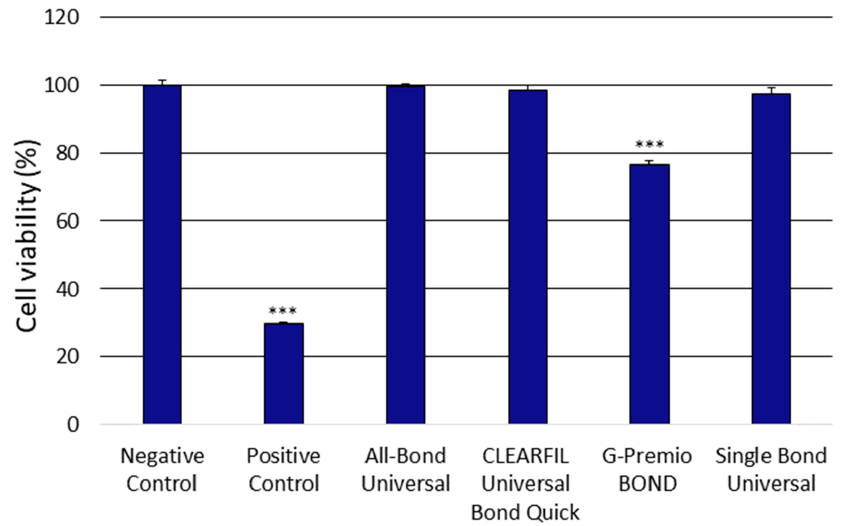
Figure 1. Cytotoxicity of the investigated adhesives. Test performed using the Cell Proliferation Kit II (XTT) assay after 24 h incubation of cells with the tested compounds. The positive control constituted cells were suspended in 96% isopropyl alcohol, while the negative control cells were cultured in a complete medium. The differences were statistically significant on the graphs as follows: *** p < 0.001 versus negative control. 3.2. Analysis of the Genotoxicity of the Universal Dental Adhesives A significant increase in DNA damage was observed after the 24 h incubation in the cells treated with G-PREMIO Bond. The other systems used did not induce significant DNA damage in the investigated SC cell line (Figure 2).